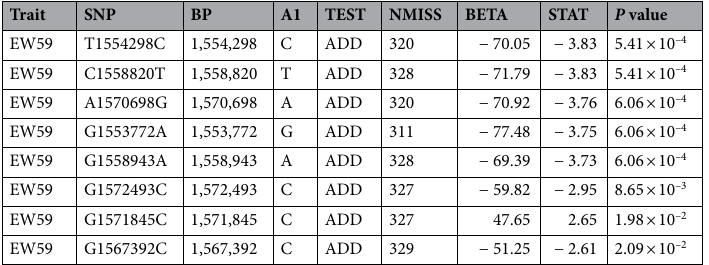
Table 3. Results of associations of the FZD6 gene with egg production traits. A1, tested allele (minor allele); ADD, additive effects of SNPs, for the additive effects of SNPs, the direction of the regression coefficient represents the effect of each extra minor allele (a positive regression coefficient means that the minor allele increases traits mean). BETA regression coefficient, STAT coefficient t-statistic, N number of non-missing individuals included in analysis, P value asymptotic P value for t-statistic after FDR